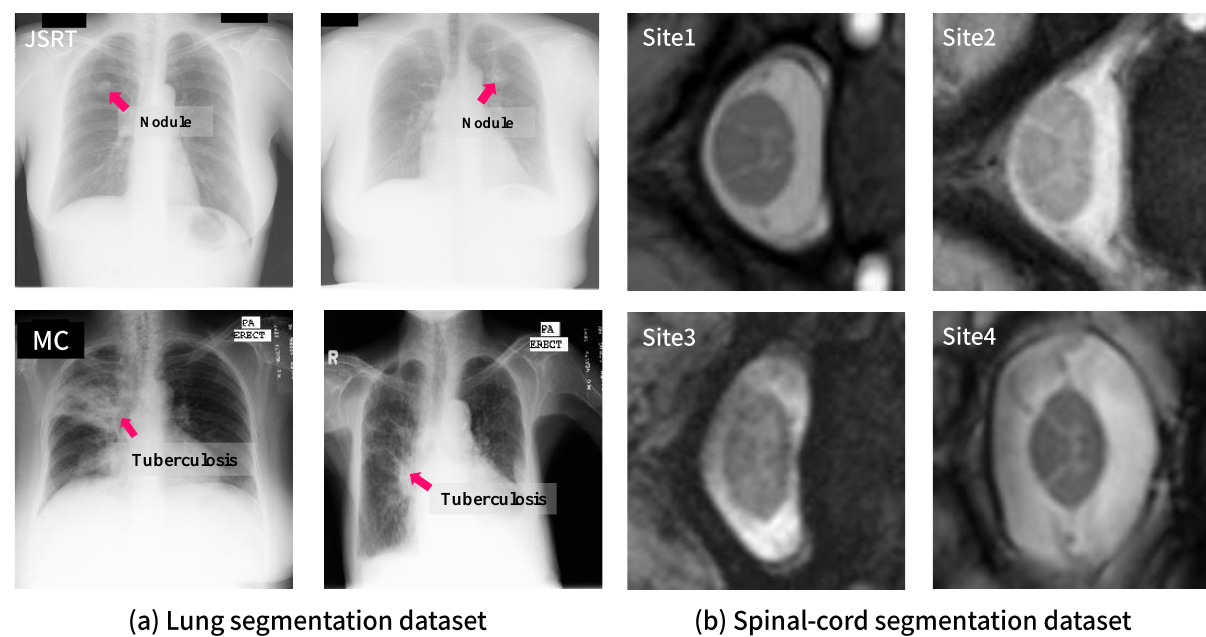
Figure 3. Examples of each dataset: ( a ) samples from JSRT ( top ) and MC ( bottom ) for lung segmentation with lesion annotations; ( b ) samples from four sites for spinal cord